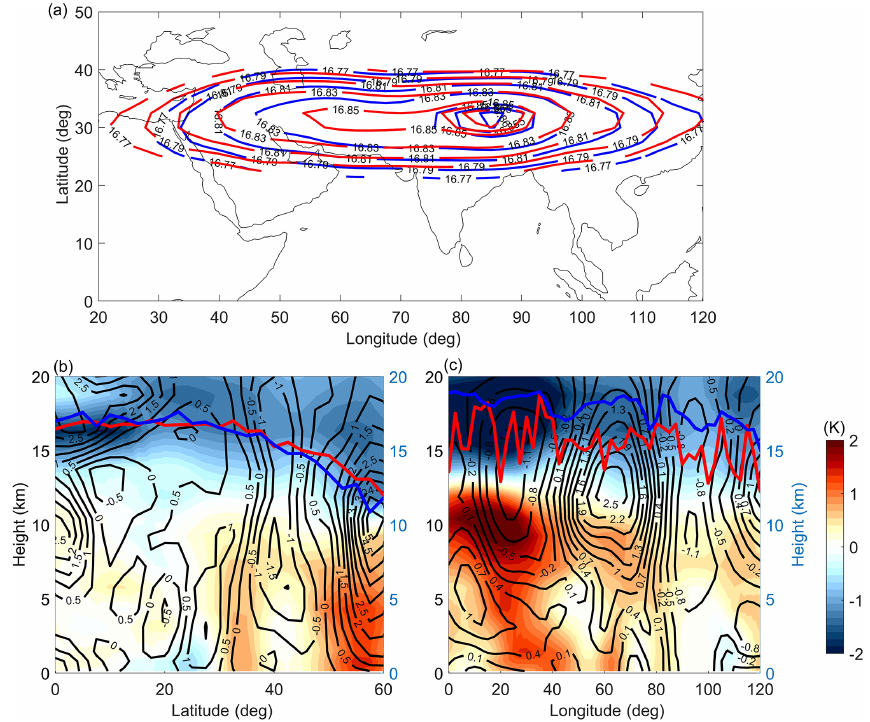
Figure 8. (a) The ASMA variability obtained from GPH at 100hPa during strong La Niña and El Niño years. The red and blue lines indicate the La Niña and El Niño years, respectively. (b) Latitude altitude cross section of temperature (colored shading, K) and zonal wind anomalies (contour lines, ms − 1 ) estimated from the difference between La Niña and El Niño years in the longitude band from 80 to 90 ◦ E. (c) Longitude–altitude cross section of temperature and zonal wind anomalies averaged between 30 and 40 ◦ N. The red and blue lines in panels (b) and (c) denote the tropopause altitude during respective La Niña and El Niño years estimated from GNSS RO